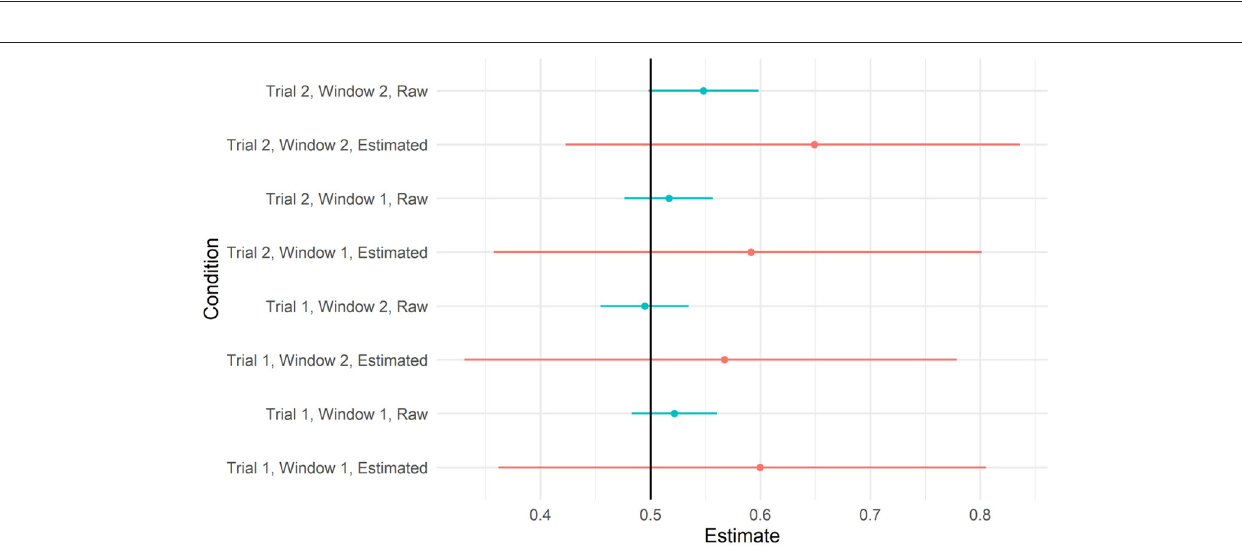
FIGURE 8 | Predicted values from the model testing the interaction between trial and window 95% credible intervals when action C was removed. Raw means and 95% CIs are plotted alongside for reference.